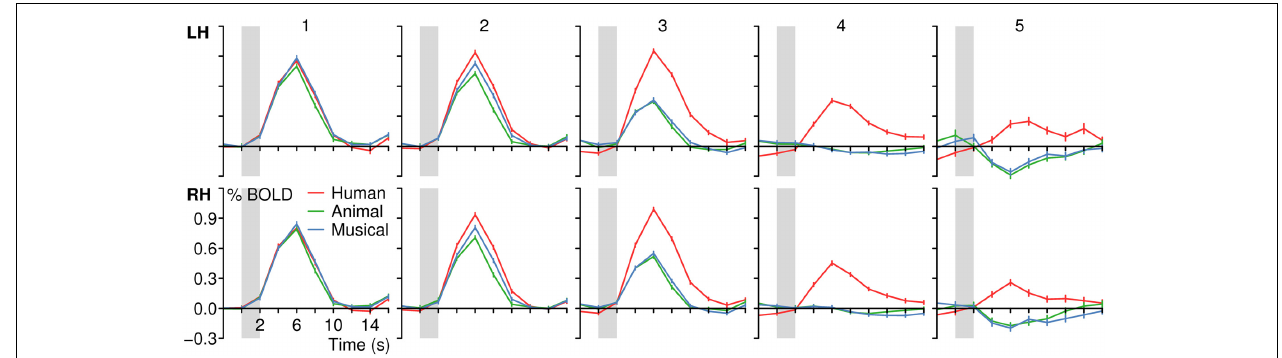
FIGURE 6 | BOLD signal time courses in different areas of the left (LH) and right (RH) temporal lobe (multi-subject analysis). For details on the origin of the different activation patterns 1–5 see Figure 5 or Table 3 . The period of stimulus presentation is indicated by gray bars.